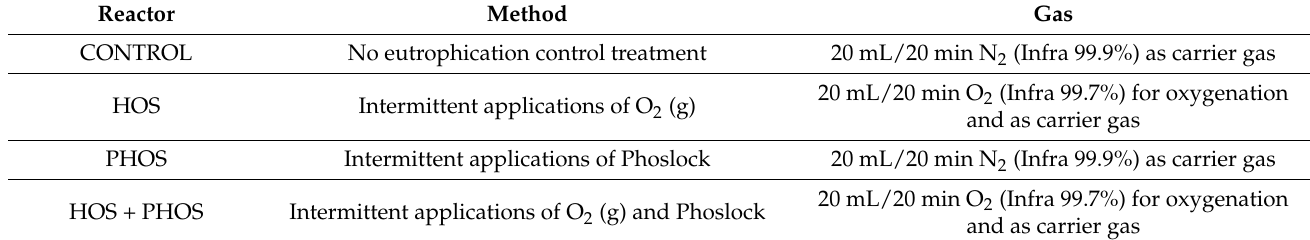
Table 3. Application of N 2 /O 2 (g) and Phoslock in experimental reactors.